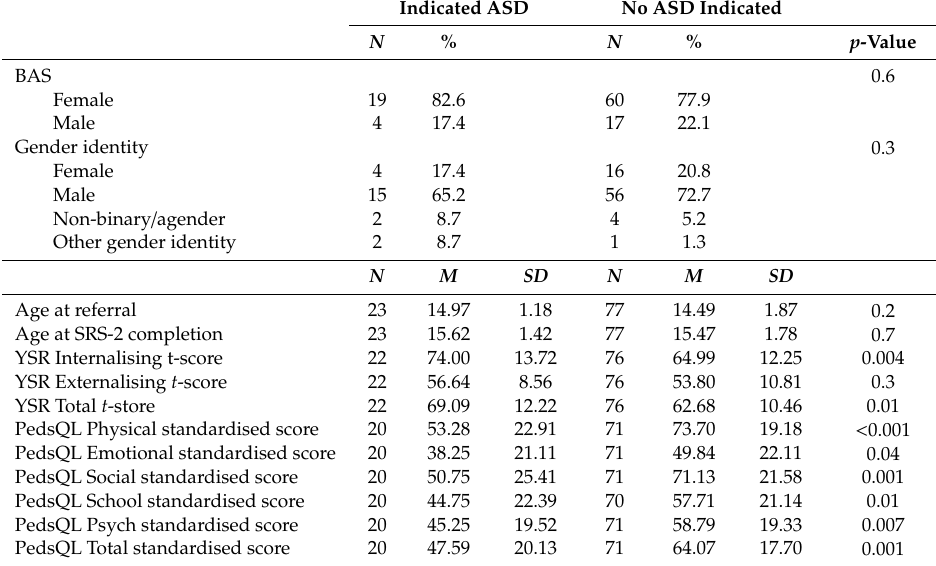
Table 3. Demographics, autistic traits, psychopathology and quality of life by indicated / not indicated ASD on the SRS-2 DSM-5 subscale. Indicated ASD No ASD Indicated N